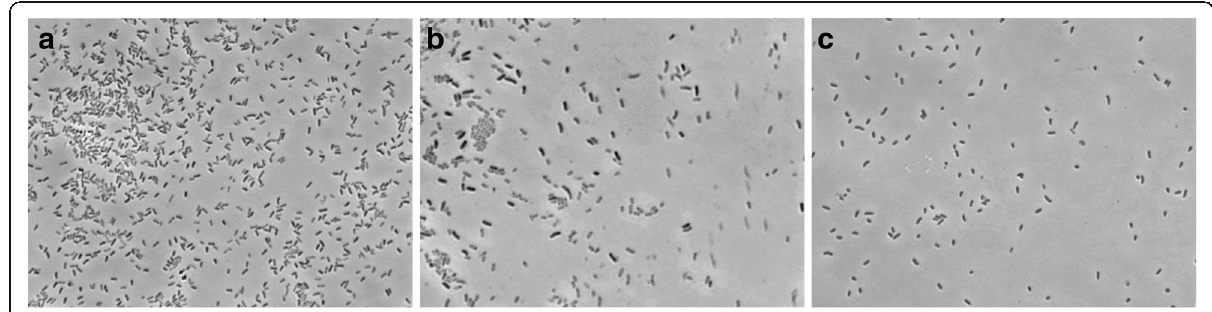
Fig. 1 Cellular morphology of S. socius SMB35 T ( a ), Salinicola sp. MH3R3 – 1 ( b ), Chromohalobacter sp. SMB17 ( c ) captured at 100×magnification. Bacteria were cultured in the RMM [8] supplemented with 3% NaCl, fixed and